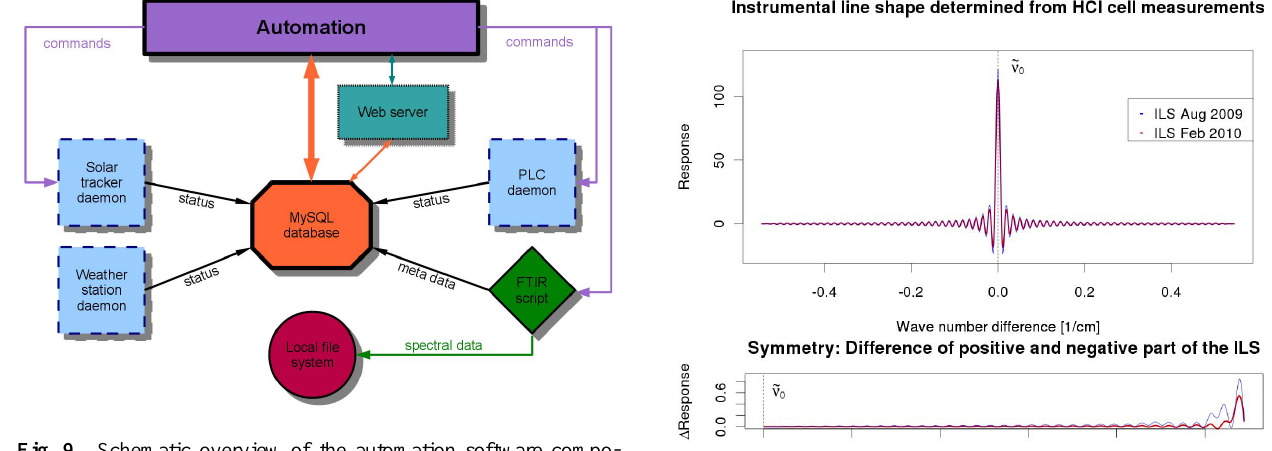
Fig. 9. Schematic overview of the automation software compo- nents.